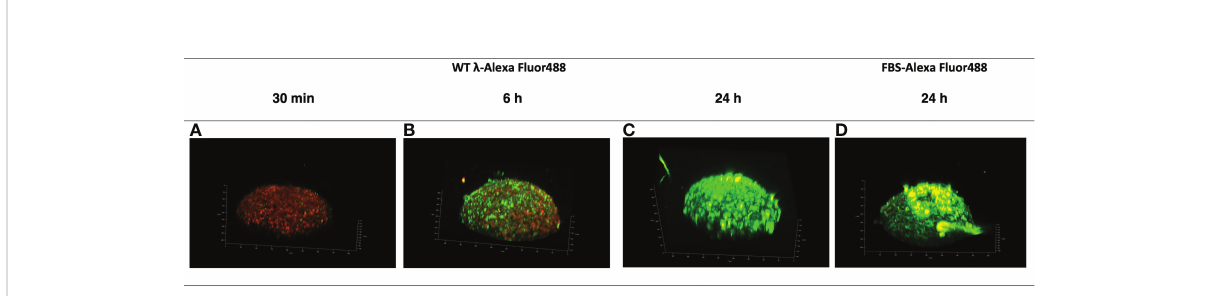
FIGURE 2 Accumulation of l phages versus FBS at the surface of NIH3T3 fi broblast spheroids. NIH3T3 spheroids (d7, 250 – 350 m m in diameter) were exposed to either WT l phages tagged with Alexa Fluor488 (A – C) or FBS tagged with Alexa Fluor488 (D) for the times shown. Spheroids were washed to discard unbound phages or FBS, and counterstained with CellTracker ™ Red prior to imaging by confocal microscopy. The 3D reconstruction is